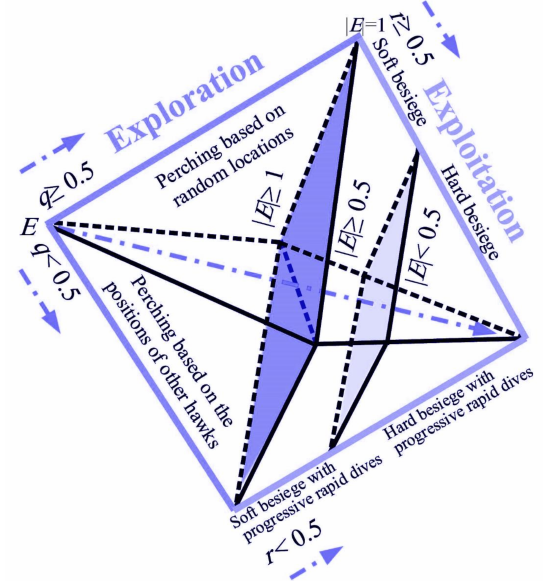
Figure 1. Overall stages of HHO